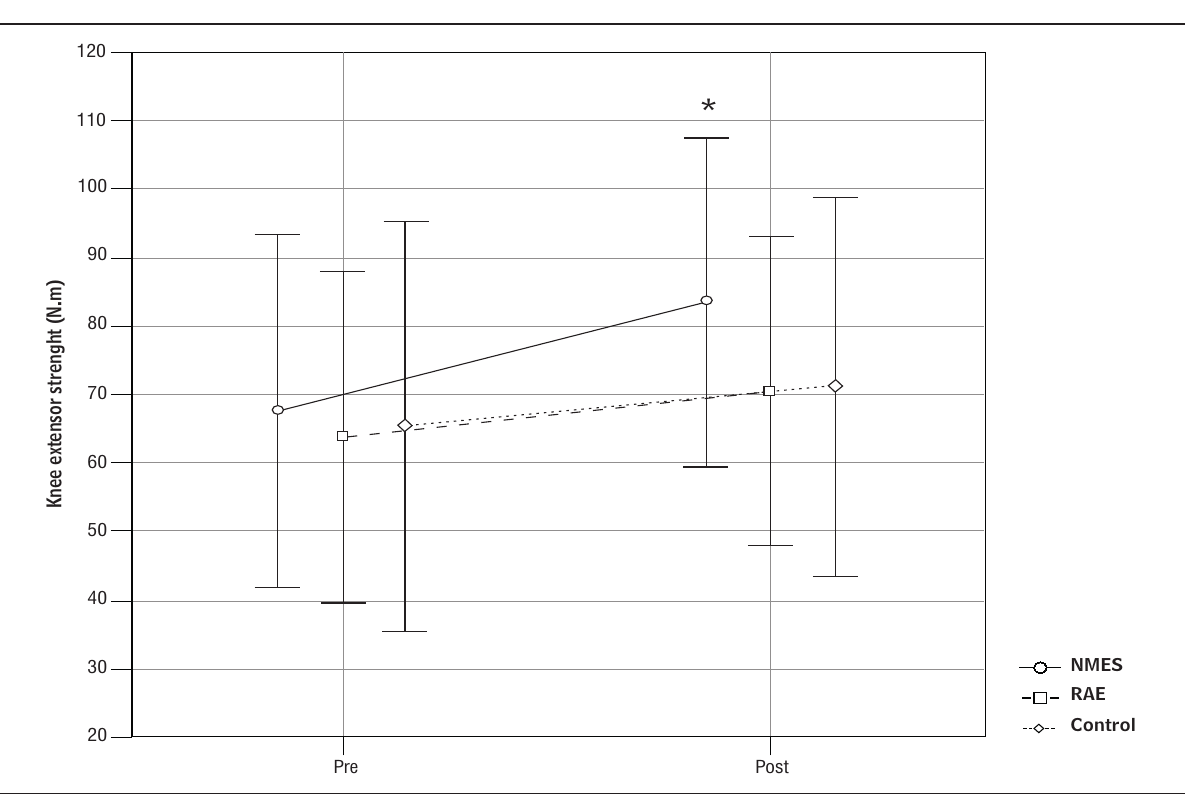
Graph 1 - Knee extensor strength before and after the 24-session program for neuromuscular electrical stimulation (NMES), resistance against exercise (RAE), and control (bars represent a confidence interval of 95 % ) Legend: * = P < 0.05